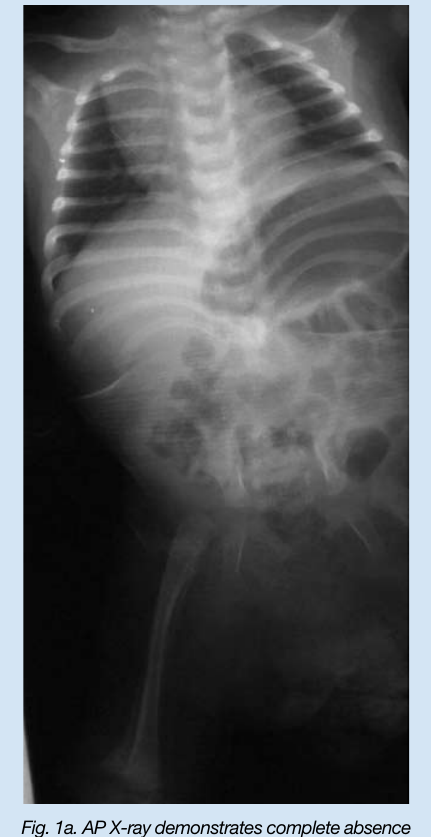
Fig. 1a. AP X-ray demonstrates complete absence of all the lumbar vertebrae and twelfth thoracic vertebrae. Eleven paired ribs are present, and the lower thoracic ribs are flared. The sacrum and pelvis are normally